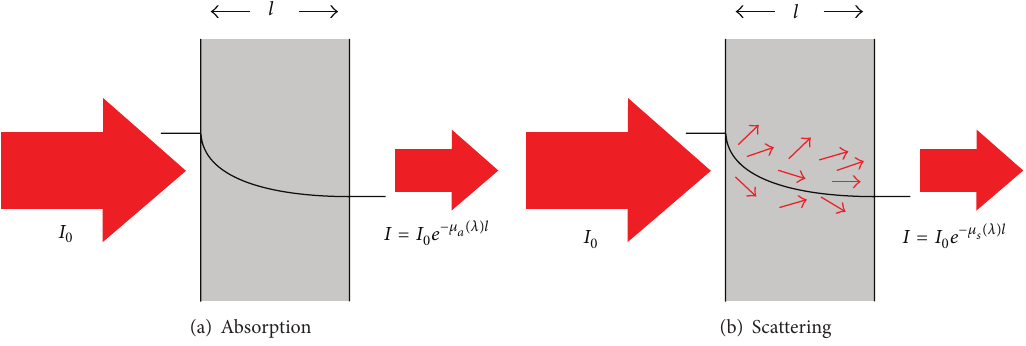
Figure 3: Macroscopic view of (a) absorption and (b)